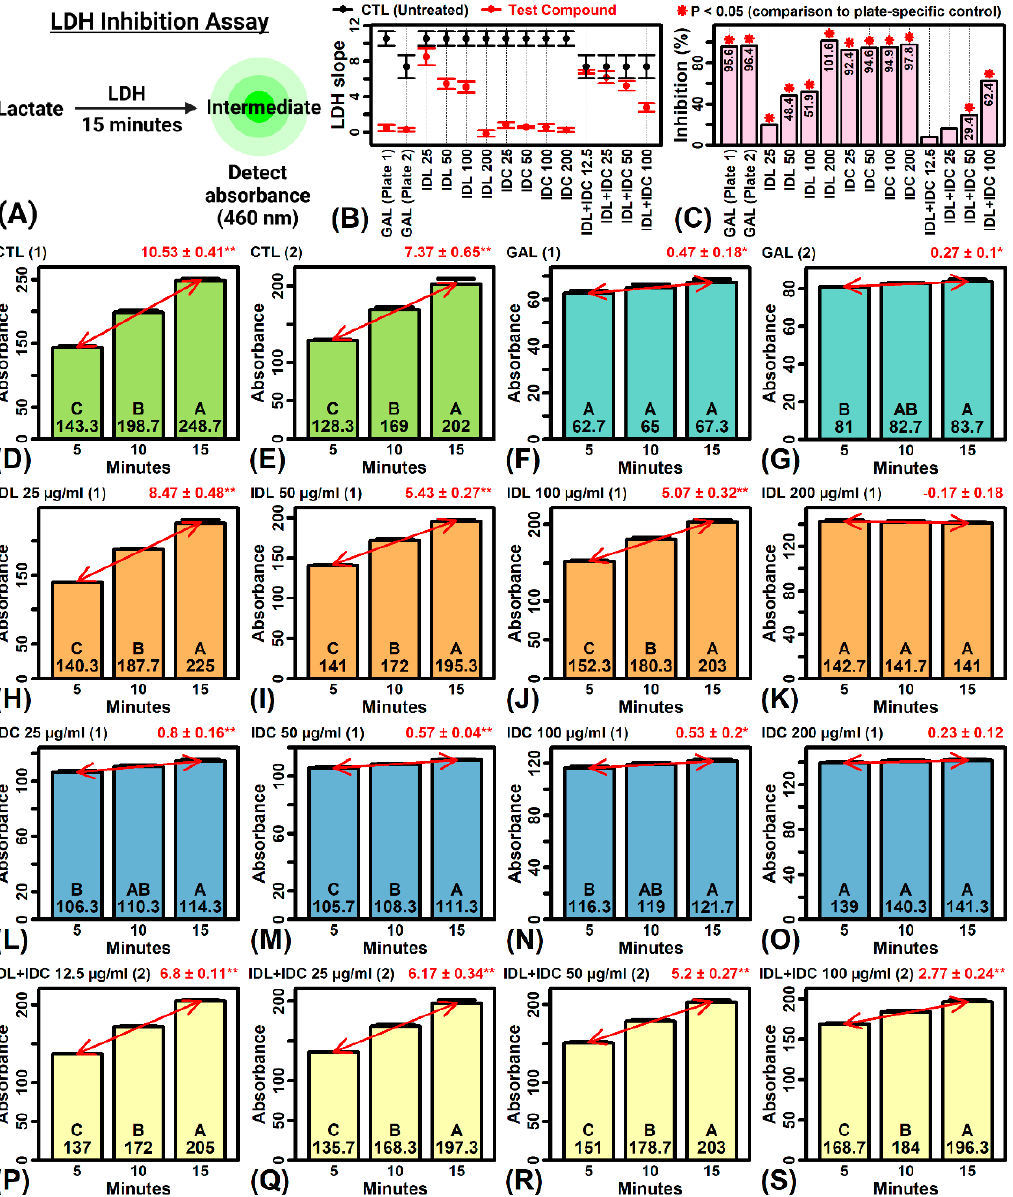
Figure 7. LDH inhibition assays. ( A ) Assay design. Lactate was converted to a fluorescent intermediate with absorbance detected at 460 nm. The reaction was allowed to proceed for 15 min, with increased absorbance (slope > 0) indicative of LDH activity. ( B ) Slope comparison (test compounds vs. CTL). Slope estimates ± 2 standard errors are plotted along with their plate-specific control. ( C ) Percent inhibition [(1-(treatment slope/CTL slope)) × 100]. The asterisk (*) is used to indicate a sig- nificant difference between treatment and CTL slope estimates ( p < 0.05, linear model two-factor